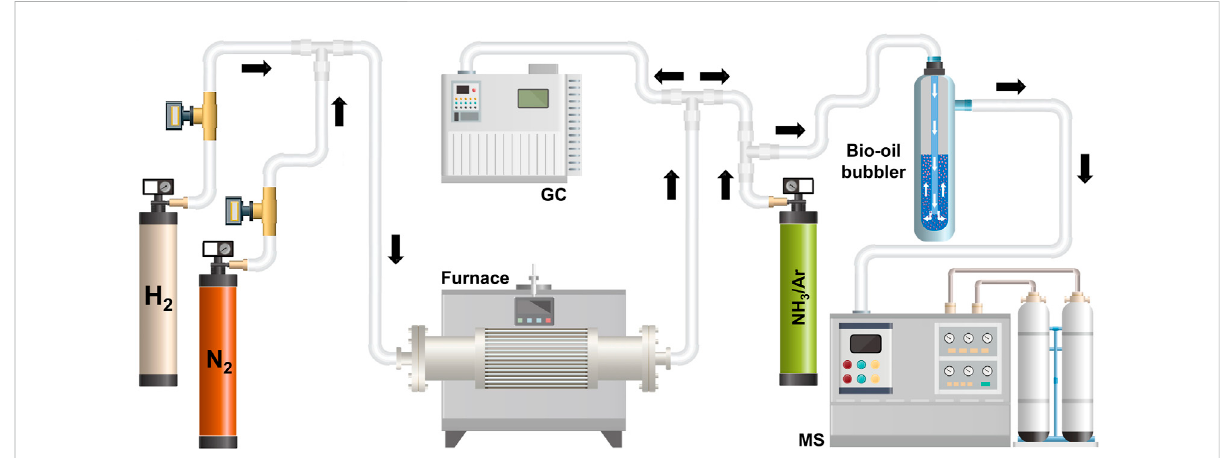
FIGURE 1 Example schematic of ammonia synthesis and analysis setup for bio-oil treatment.